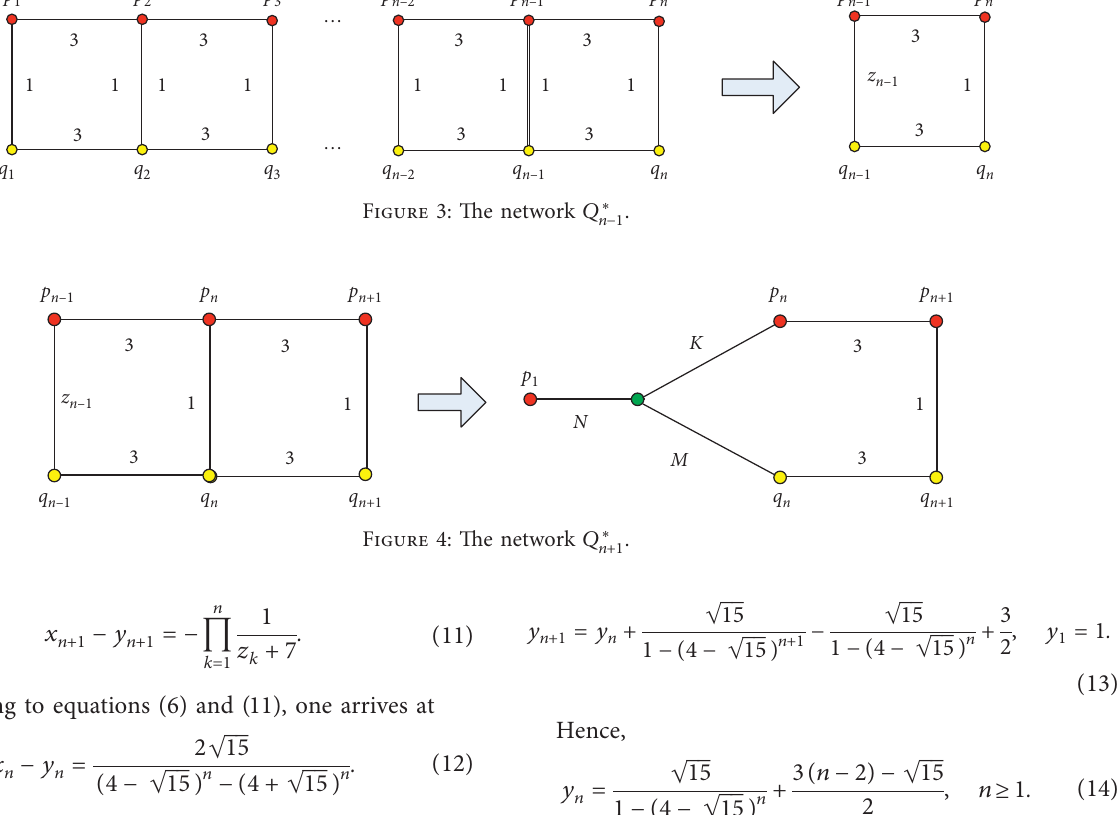
Figure 2: Linear polyomino network Q ∗